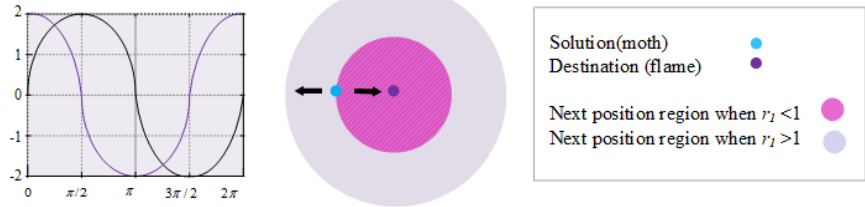
Figure 4. The basic principle of sine–cosine strategy.